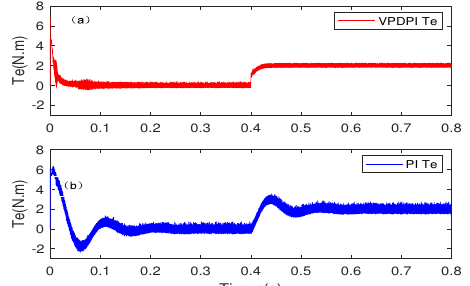
Figure 29. Torque response process under two control methods. ( a ) Torque response under the proposed VPDPI control. ( b ) Torque response under the PI control. From the above experimental results, the control performance of the two regulators is similar to the above two working